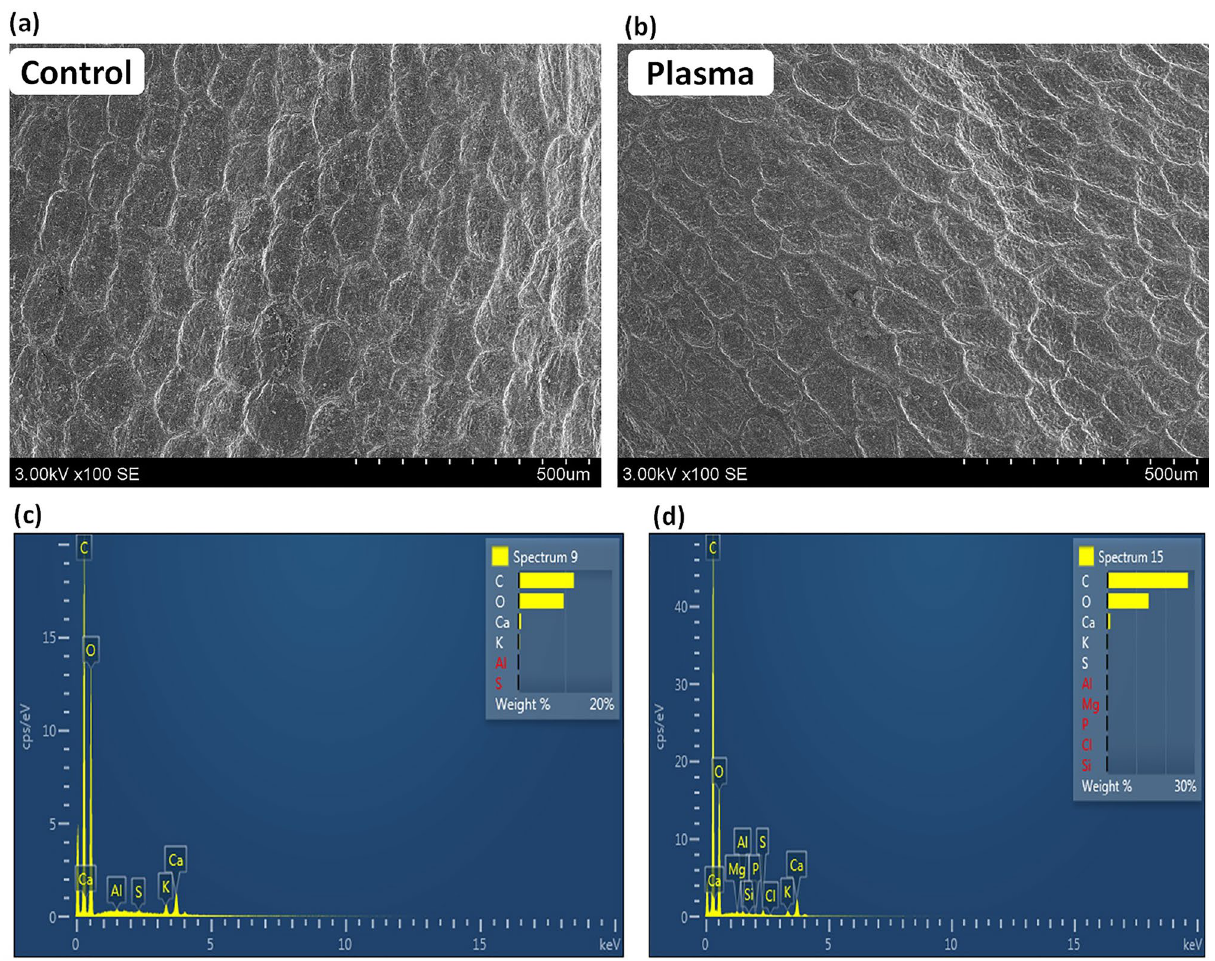
Figure 6. SEM image of radish seeds (a) control; (b) after plasma treatment; EDX spectra of (c) grey seed control and (d) after plasma treatment.